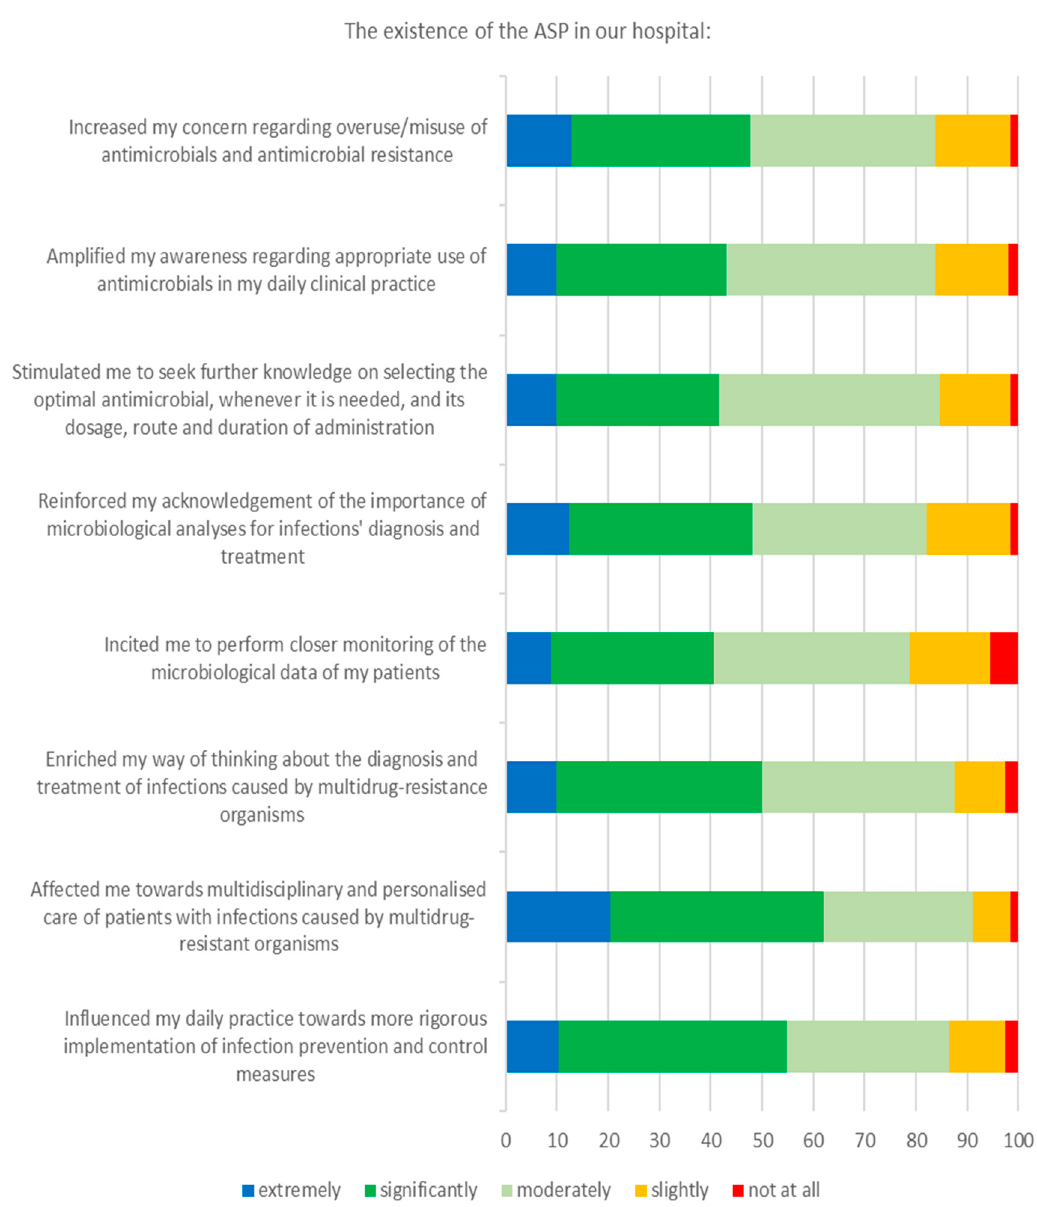
Figure 4. Respondents’ attitudes and practices towards the management of patients with MDRO infections.